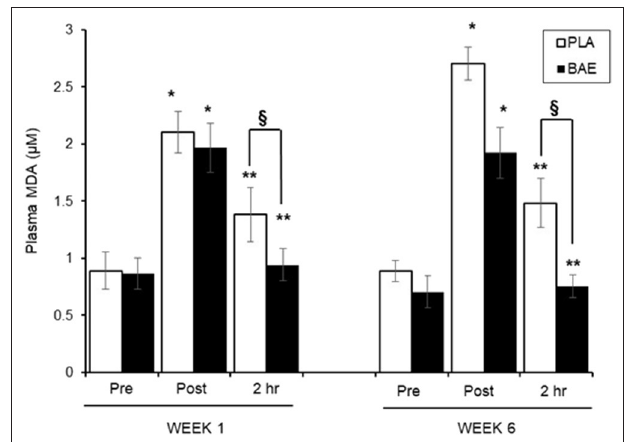
FIGURE 2 | The influence of blackcurrant anthocyanin-rich extract (BAE) or placebo (PLA) consumption 1h prior to exercise on plasma malondialdehyde (MDA) levels on week 1 and 6 after 5 weeks daily consumption. Results are expressed as mean ± SEM, n = 18 individuals per group. * p < 0.05 represents statistical difference from corresponding pre-exercise values. ** p < 0.05 represents statistical difference from corresponding post-exercise values. § p < 0.05 represents statistical difference between PLA and BAE